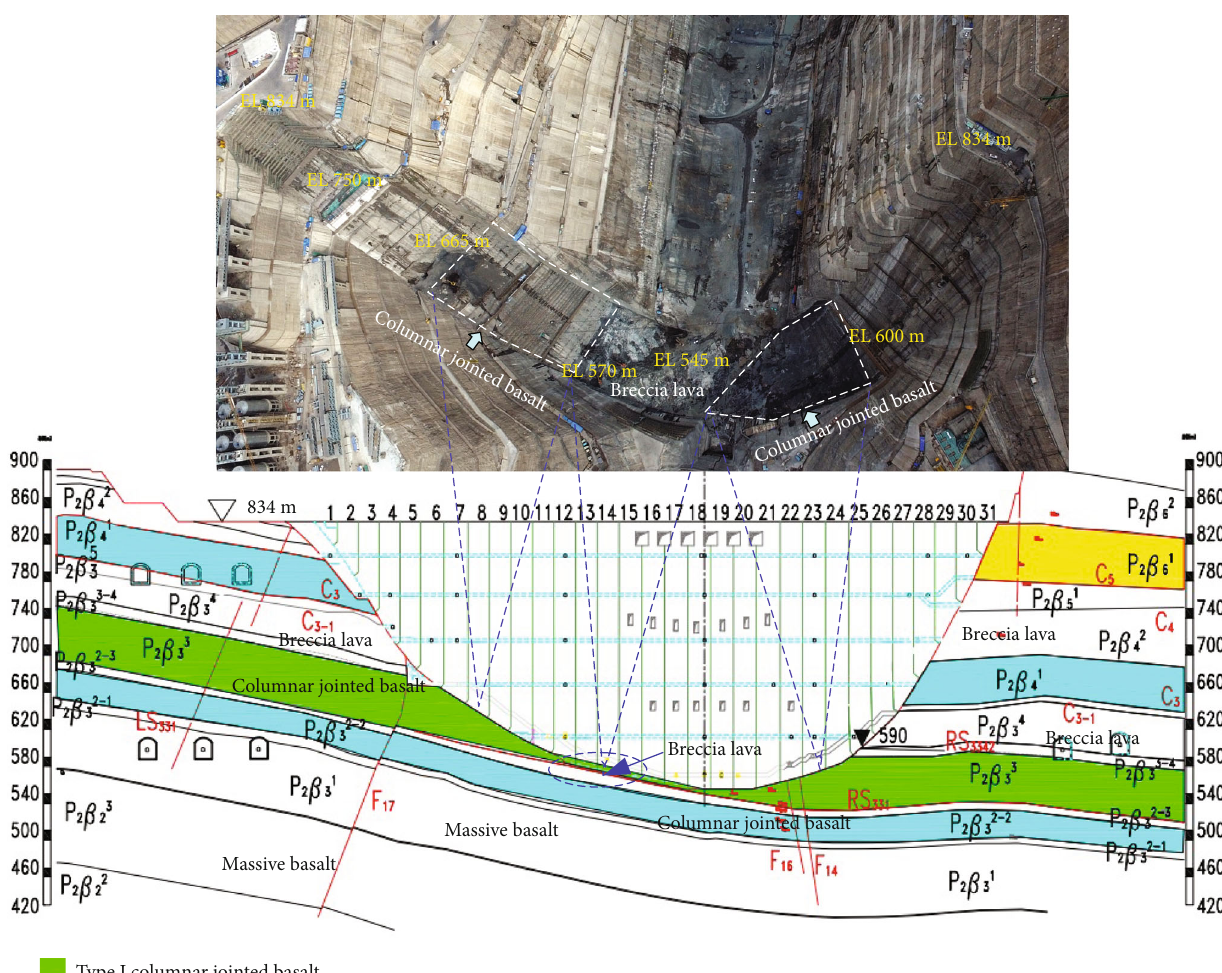
Figure 3: Geological condition of Baihetan hydropower station.